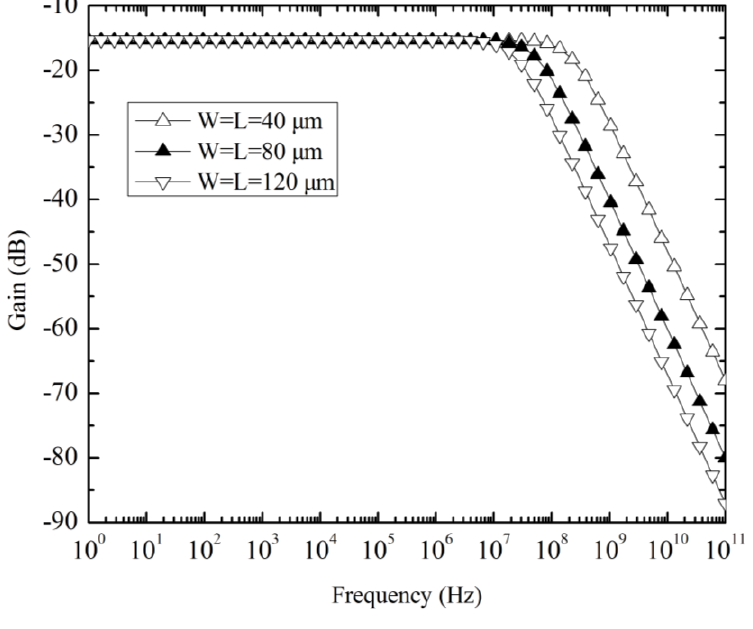
Figure 8. Ac simulation gain versus frequency for three Hall plates with different